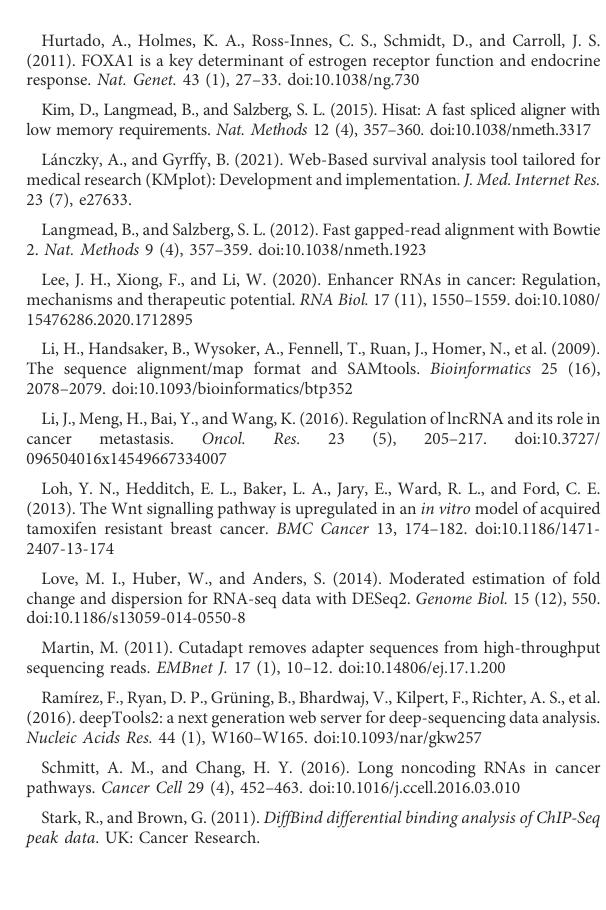
The KM survival curve of CASC15 (A) , KCTD21 − AS1 (B) , and LINC00885 (C) using the luminal breast cancer treated with endocrine therapy